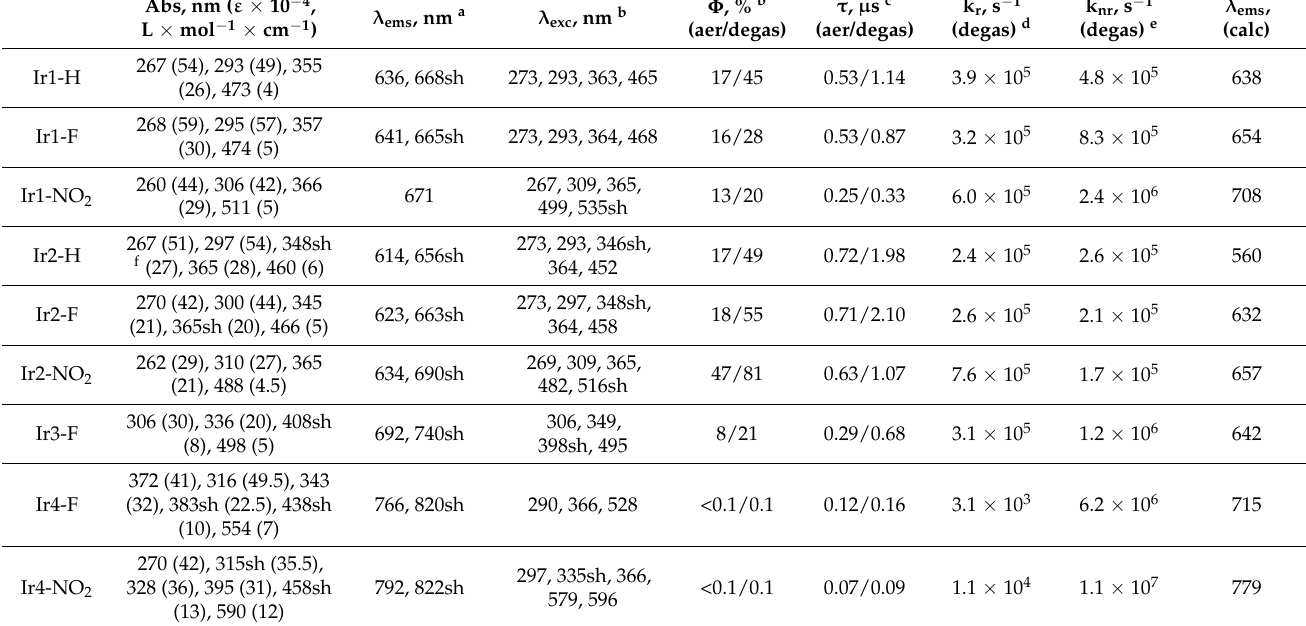
Table 1. Photophysical data for iridium complexes, 298 K, dichloromethane